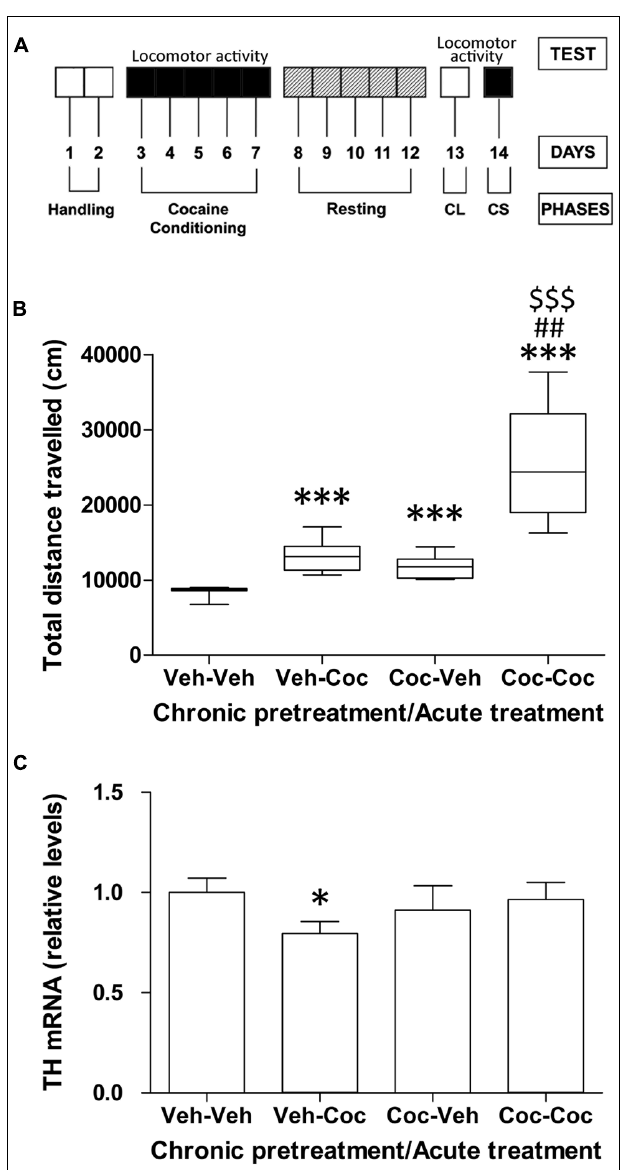
FIGURE 1 | (A) Schematic representation of the different phases of cocaine behavior such as acute cocaine administration (10 mg/kg), cocaine conditioning (20 mg/kg), resting, conditioned locomotion (CL) and cocaine sensitization (CS, 10 mg/kg). (B) Effect of acute cocaine administration (chronic vehicle + acute cocaine), CL (chronic cocaine + acute vehicle) and cocaine sensitization (chronic cocaine + acute cocaine) on distance traveled for 30 min measured in the Open Field. Box-and-whisker diagram represents the statistical distribution of the data ( n = 8/group). Newman–Keuls: ∗∗∗ P < 0.001 vs. vehicle–vehicle group, ## P < 0.01 vs. vehicle–cocaine group, $$$ P < 0.001 vs. cocaine–vehicle group. (C) Relative mRNA levels of the catecholamine synthesizing enzyme tyrosine hydroxylase (TH) in the mouse cerebellum after chronic pretreatment (vehicle and cocaine) and acute treatment (vehicle and cocaine). Histograms represent the mean ± SEM ( n = 8/group).Two-way ANOVA: ns, no significance. Bonferroni: ∗ P < 0.05 vs. vehicle–vehicle